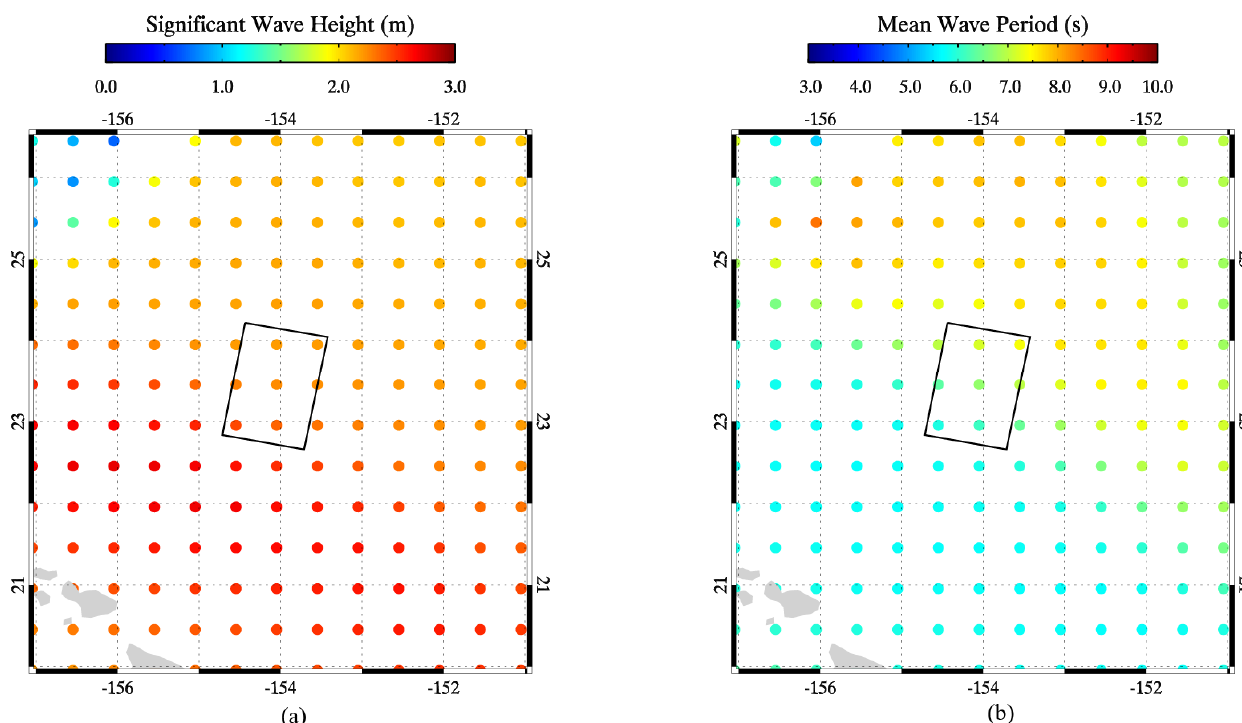
Figure 4. WAVEWATCH-III result of the case, taken at 4:19 p.m. UTC on 13 December 2010, is shown and the black rectangle is the geographic location of TS-X: ( a ) SWH information and ( b ) MWP information. 3. The comparison between SAR-derived and in situ buoy